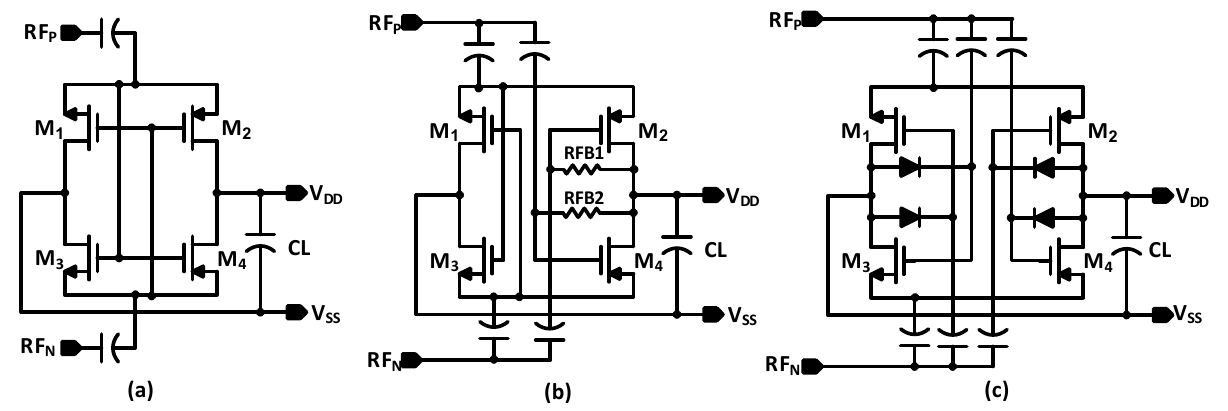
Figure 2. Schematic of ( a ) a conventional FX rectifier; ( b ) a self-biased rectifier; ( c ) an FB diodes rectifier.